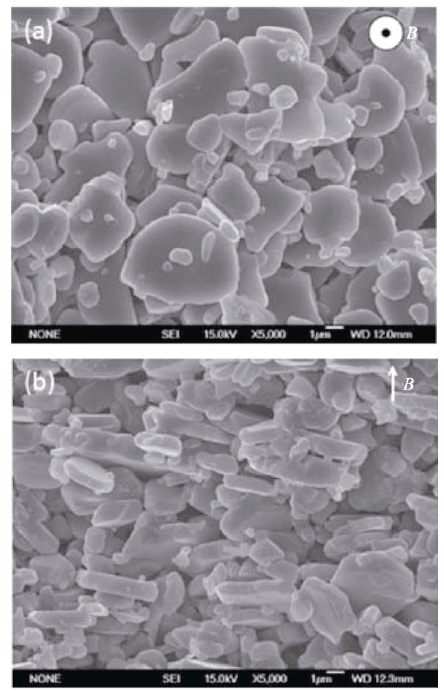
Fig. 3 SEM fracture morphologies of textured alumina ceramics: (a) perpendicular to the magnetic field direction; (b) parallel to the magnetic field direction. Reproduced with permission from Ref. [69], © WILEY ‐ VCH Verlag GmbH & Co. KGaA, Weinheim